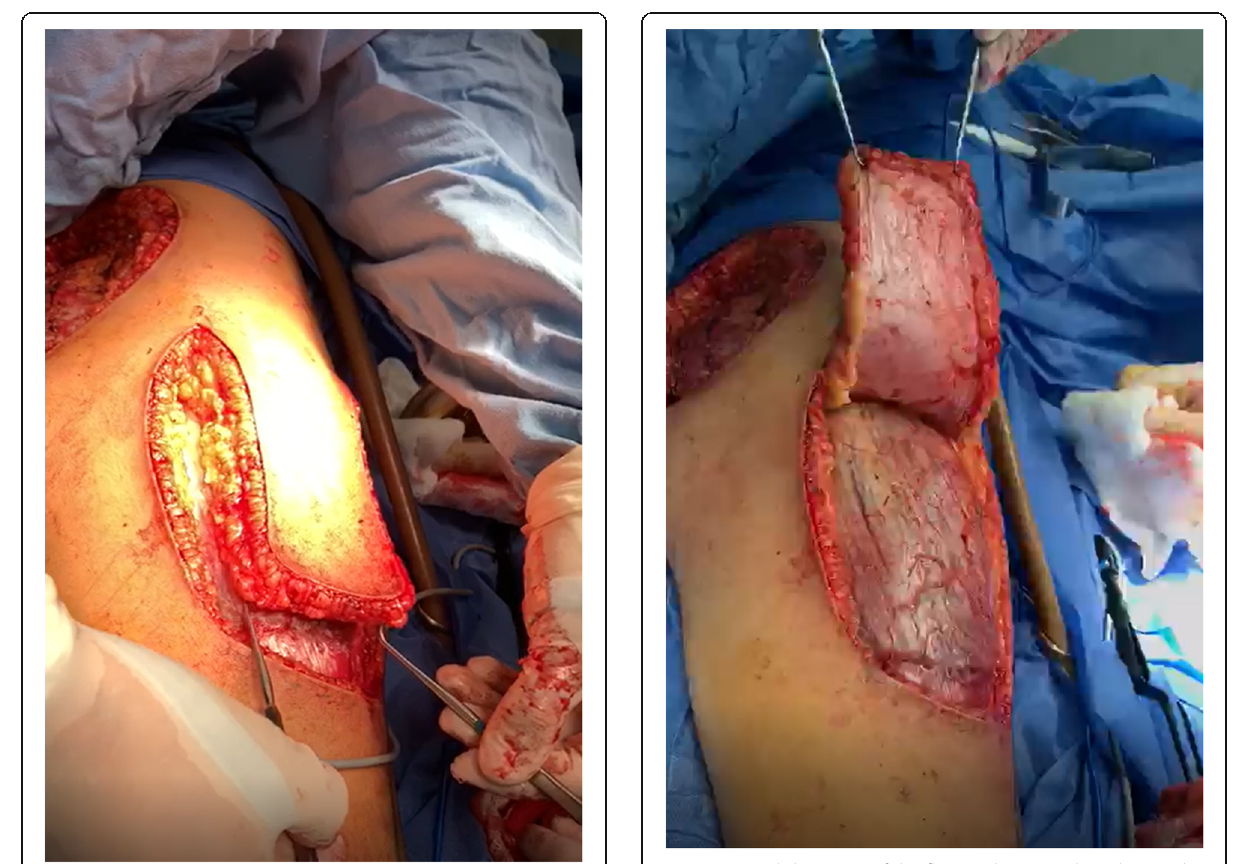
Fig. 6 Proximal dissection of the flap on the vastus lateralis muscle, in the subfascial